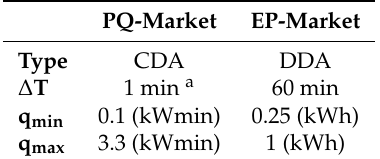
Table 2. Main parameters of integrated